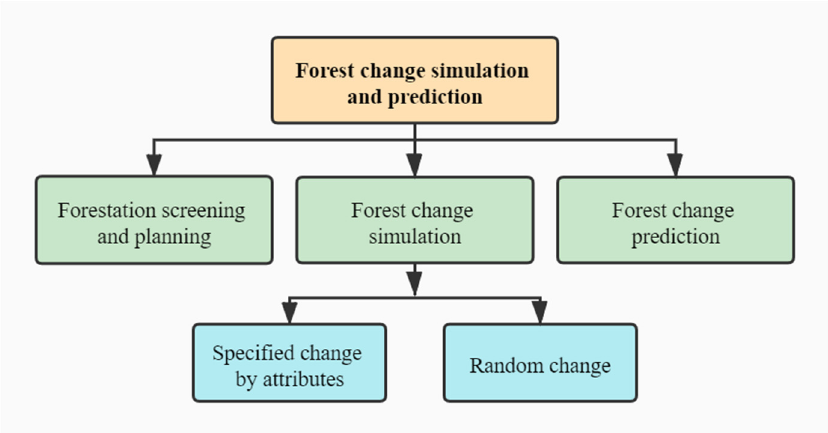
Figure 2. Forest change simulation and prediction.